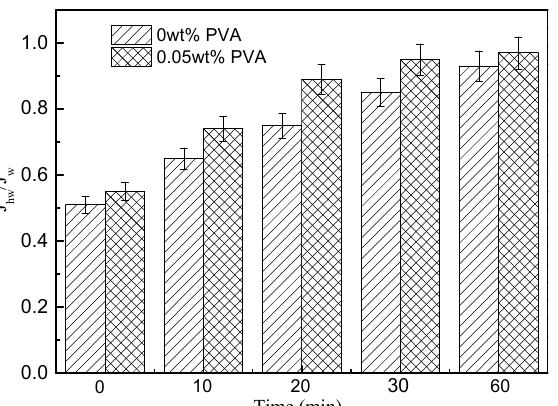
Figure 12. Effect of operation time on J hw /J w of PVA 0 wt% and PVA 0.05 wt% conductive membrane.